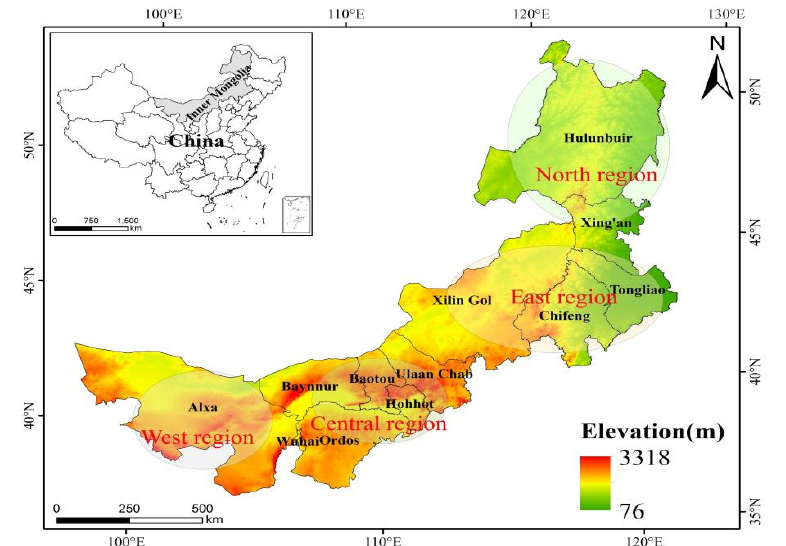
Figure 1. Location of the study area.